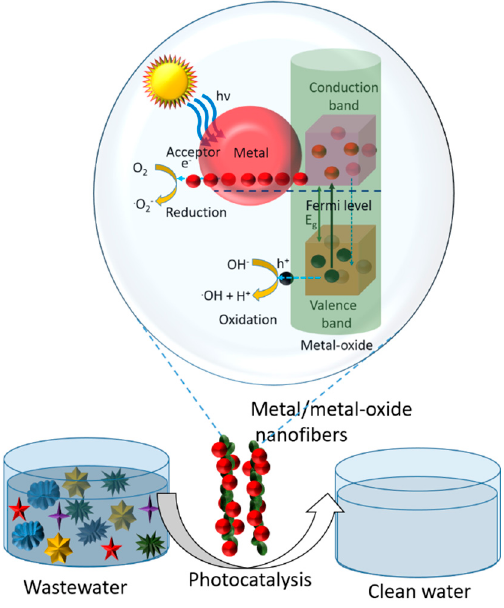
Figure 10. Scheme diagram of the electron transfer mechanism of the metal–metal oxide nanofibers.